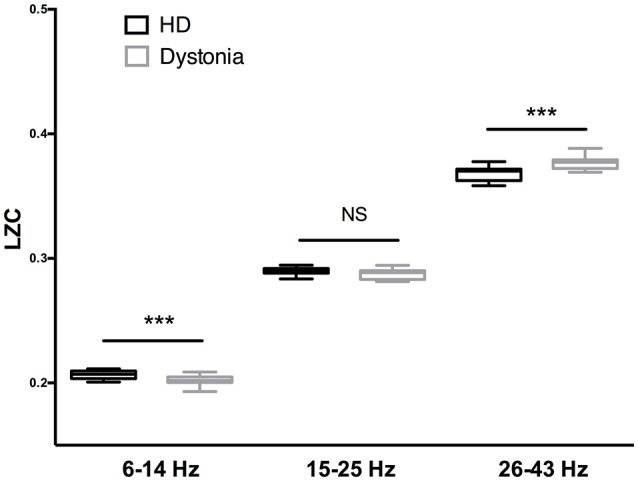
Complexity analysis of HD and dystonia LFPs centered on the peak frequency in 6–14, 15–25, and 26–43 Hz bands. Significant differences in LZC were found between HD and dystonia groups at 6–14, 15–25, and 26–43 Hz [F(5, 90) = 28.18, p < 0.0001, one-way ANOVA]. The LZC of the 6–13 Hz band was significantly lower in the dystonia group than the HD group (t-tests, p ≤ 0.001). The LZC values in the high-beta and low-gamma bands were significantly higher in the dystonia group than the HD group (t-tests, ***p < 0.001).